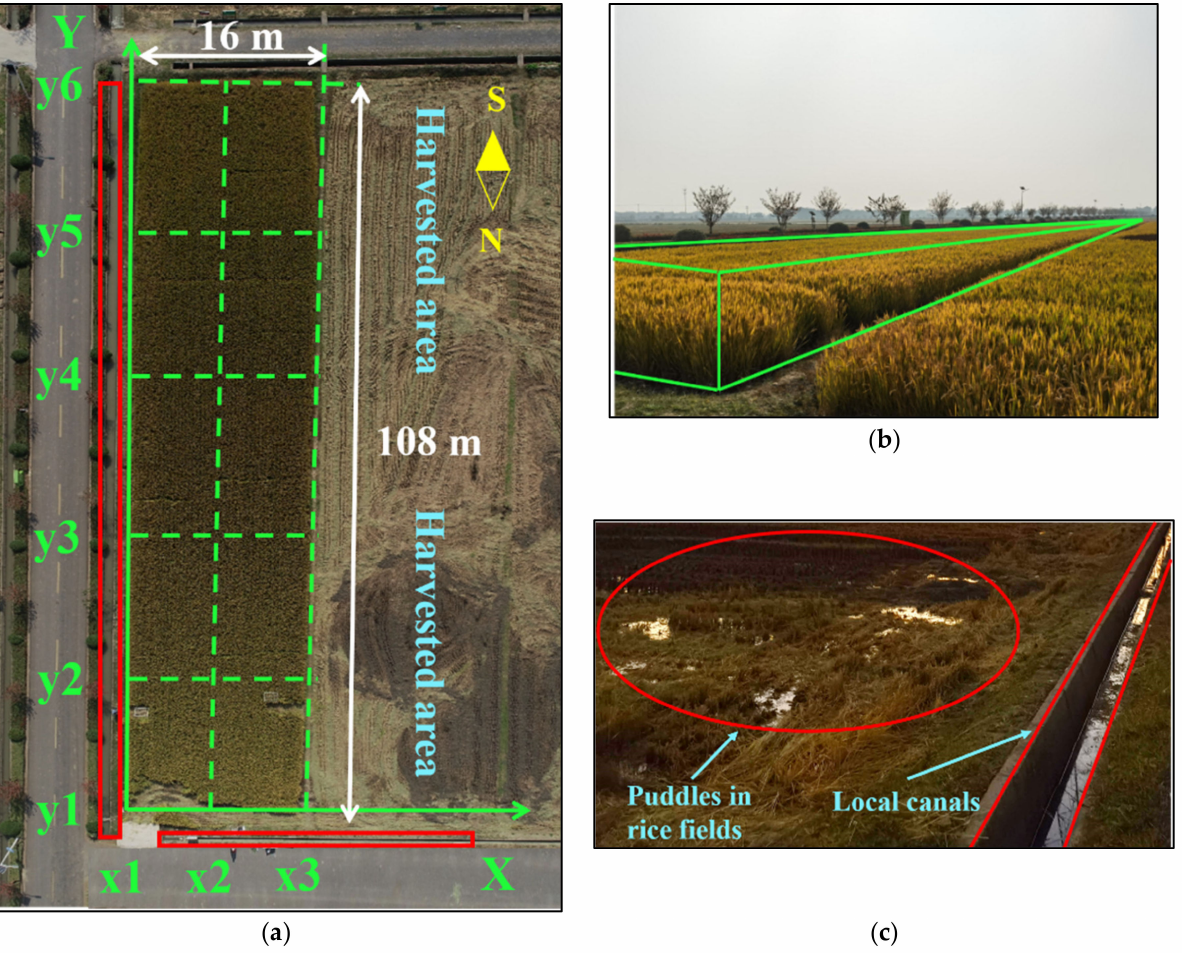
Figure 1. The experimental field: ( a ) Aerial view; the red lines denote the canals, and the points intersected by the green dotted lines represent the sampling points; ( b ) detailed view of the field; the area within green lines is the test field; ( c ) detailed view, showing the water in the canal and field. The experimental field was well-maintained and differed from the surrounding en- vironment. Chessboard sampling was used to measure the water content and other pa- rameters of rice (Figure 1a). According to the distance to the water source and ventilation characteristics, the field was divided into three equidistant columns, marked as x1, x2, and x3 from left to right. According to the received sunlight, the field was equally divided